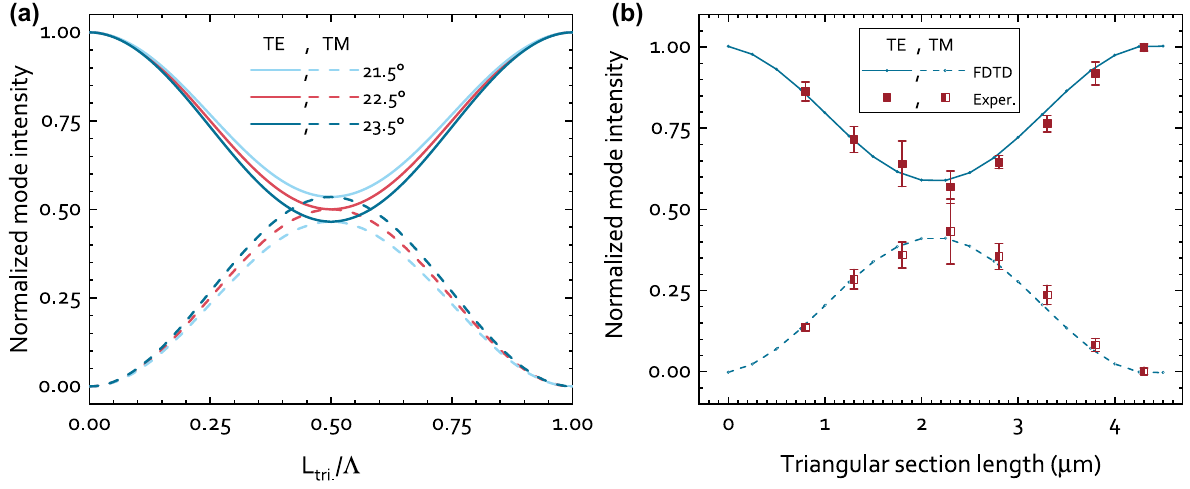
Figure 8: (a) Modelled mode conversion as a function of triangular cross-section waveguide length showing the case for different values of 𝛼 . Note that the beating length L is indicated by Λ . (b) FDTD simulation and experimental evidence showing mode conversion as a beat . cs function of triangular cross-sectioned waveguide length. Error bars are defined by measuring 3 sets of identical devices. Both graphs assume TE mode